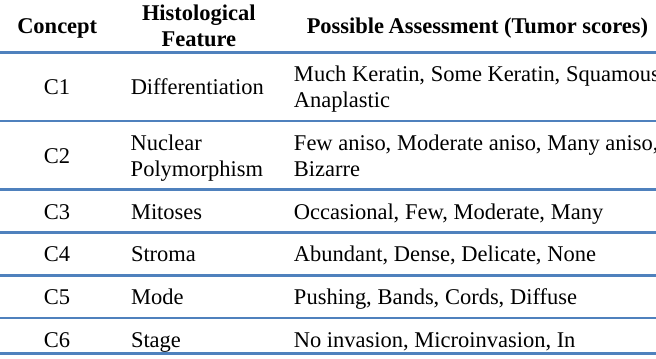
Table 1. FCM for Oral Tumor